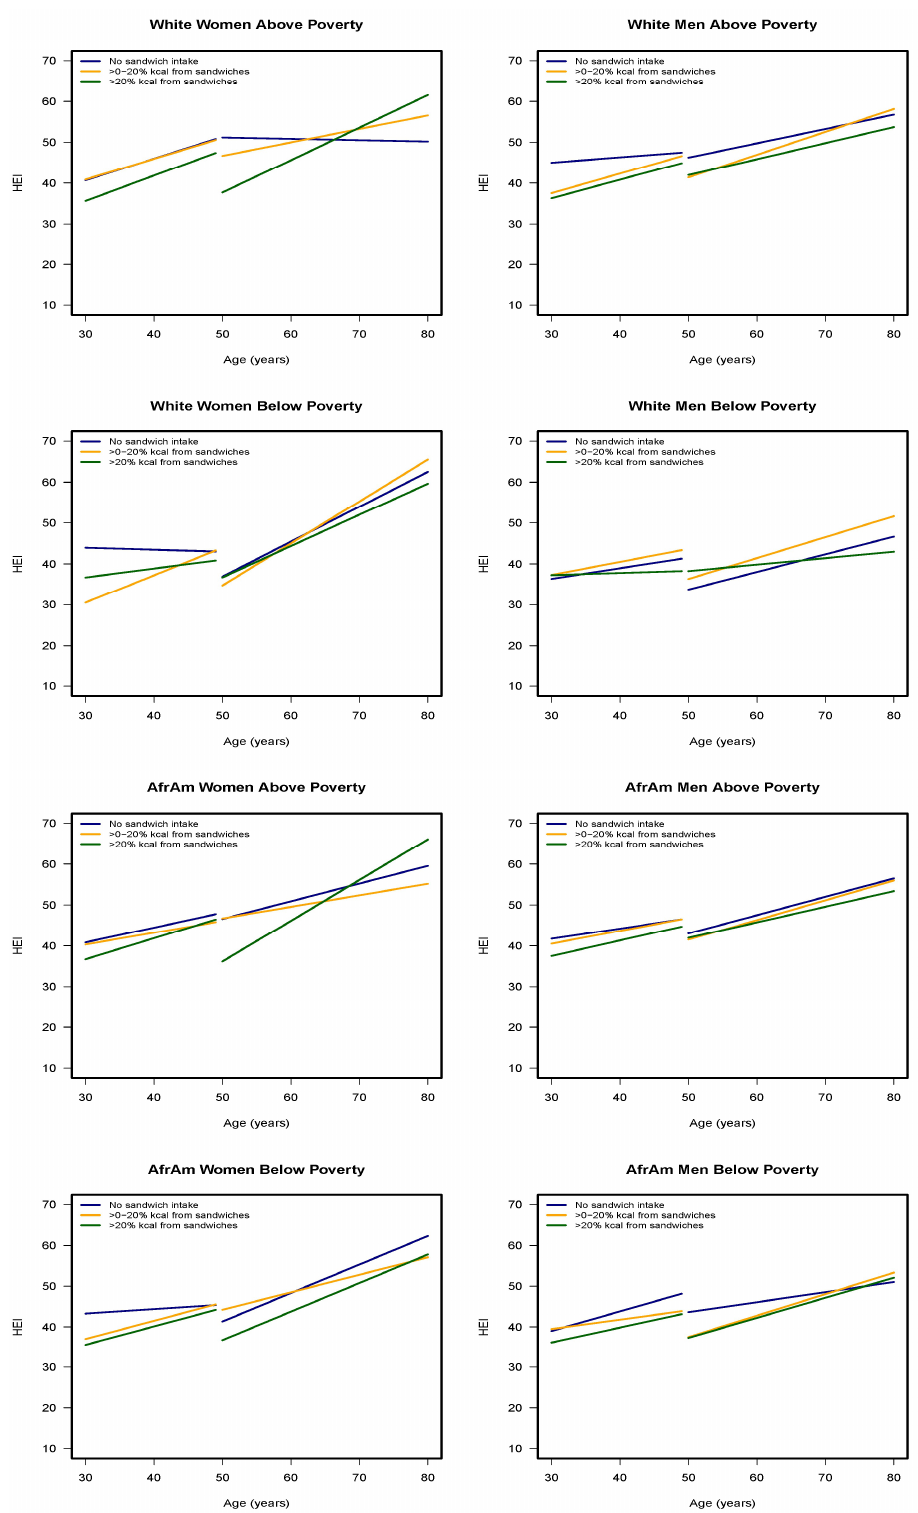
Figure 1. Healthy Eating Index (HEI) scores across three visits of the HANDLS study (2004–2017). For African American and White men and women by initial age cohort ( < 50 or ≥ 50 years at visit one) and by poverty ( < 125% or > 125% poverty threshold) for three levels of energy intake (0%, > 0–20%, > 20% kcal) contributed by sandwiches. HANDLS-Healthy Aging in Neighborhoods of Diversity across the Life